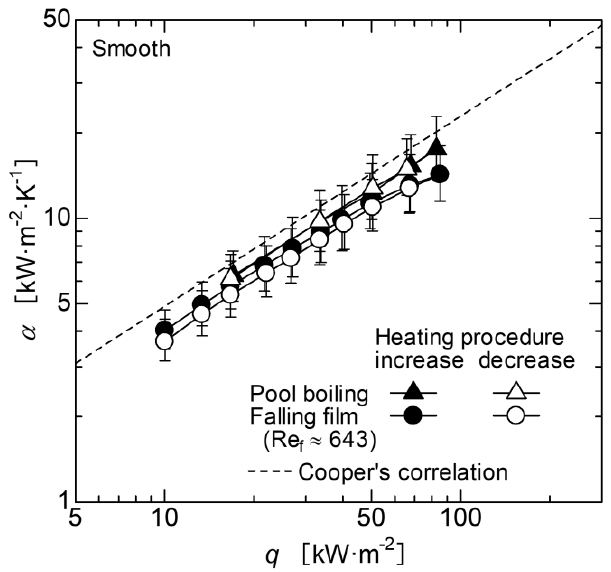
Figure 8. Pool boiling heat transfer coefficients in comparison with those for falling film evaporation on the smooth tube.